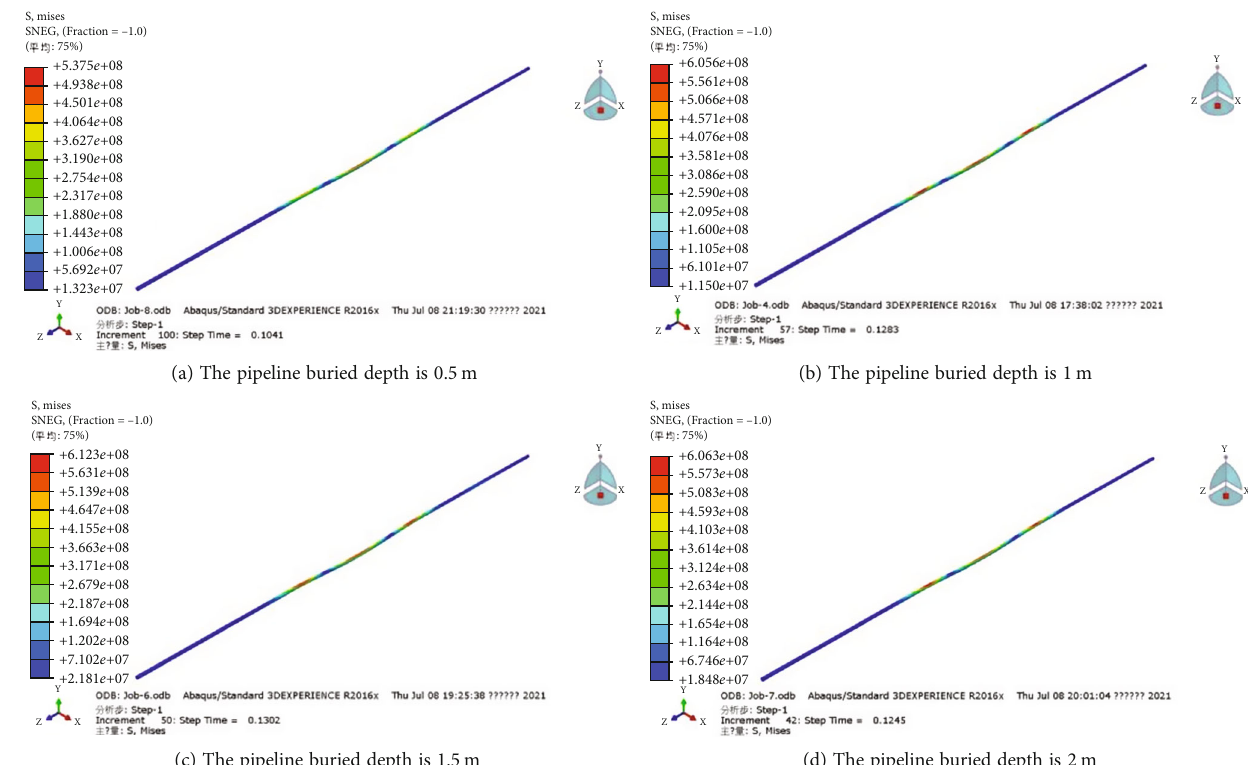
Figure 26: The pipeline stress under di ff erent pipeline buried